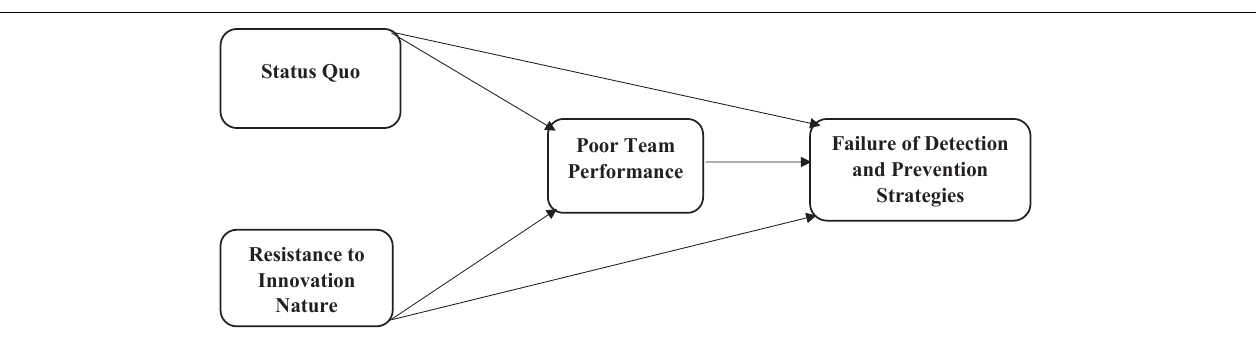
FIGURE 1 | The value of Pharma products exported from Malaysia.